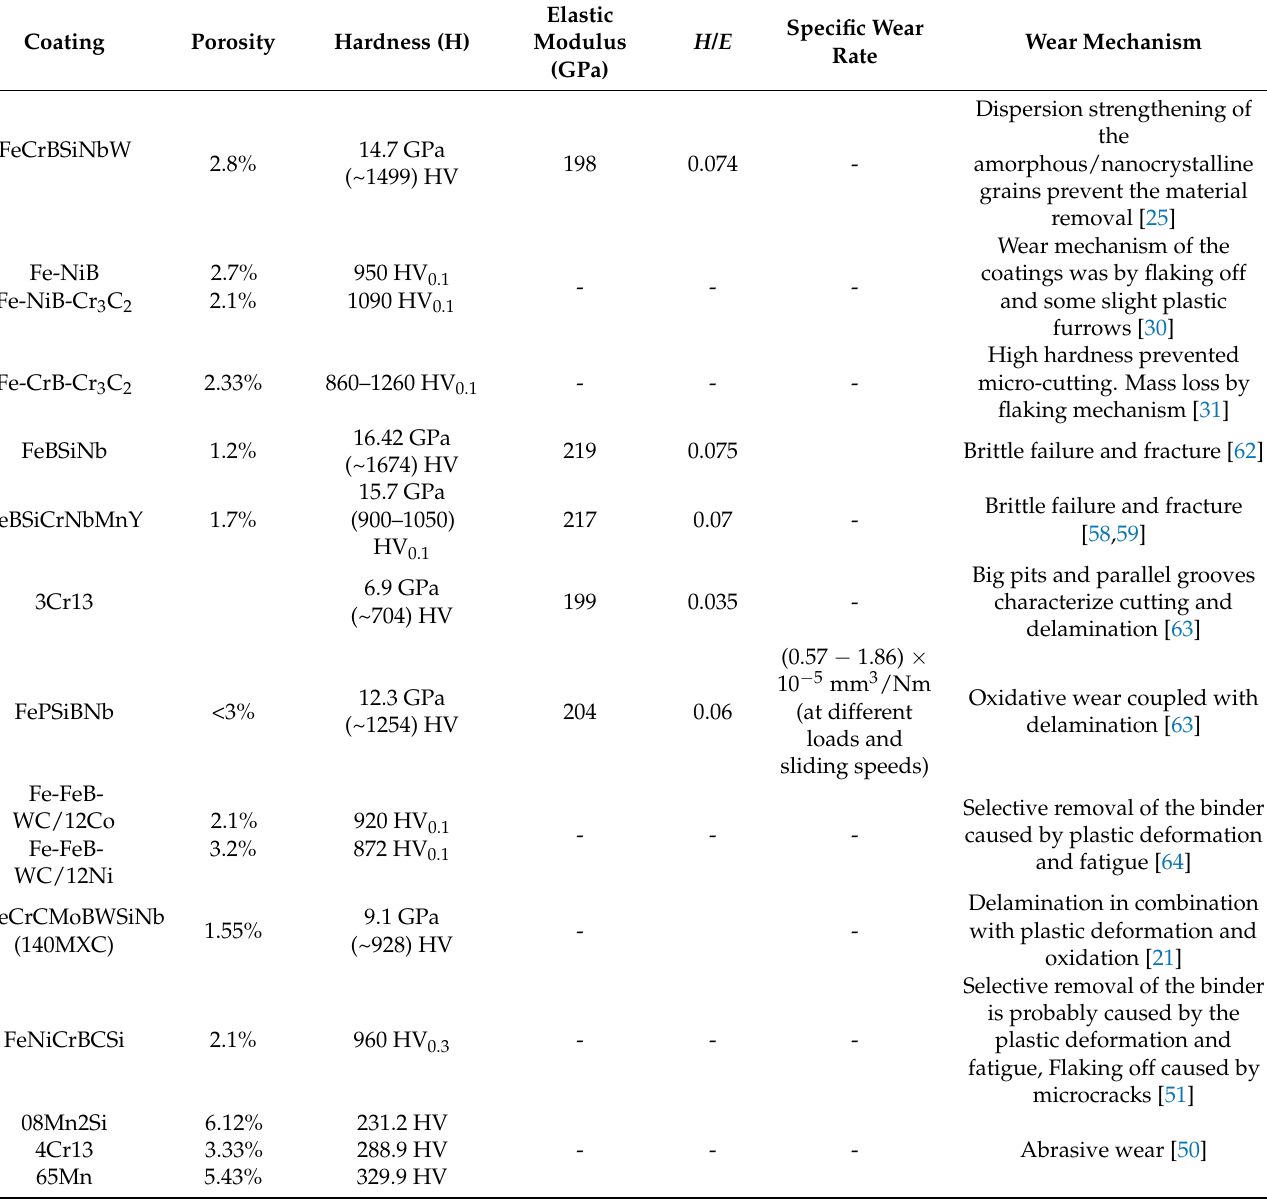
Table 2. Summary of the wear and mechanical properties of the arc-sprayed Fe-based coatings.